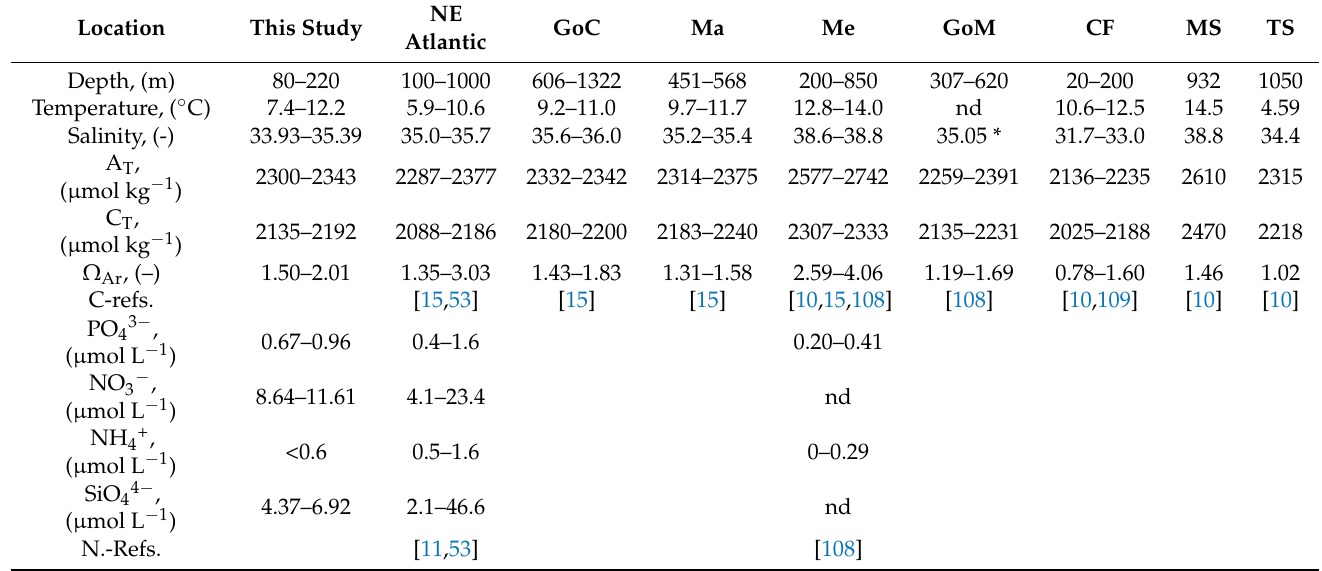
Table 5. The range (published min–max) of environmental conditions at different regions, specifically at the depth and site of known Lophelia pertusa, Madreora oculata, or Desmophyllum dianthus occurrences, comparing data from this study with data available in the literature. Abbreviations: GoC: Gulf of Cadiz, Ma: Mauretania, Me: Mediterranean, GoM: Gulf of Mexico, CF: Chilean Fjords, MS: Marmara Sea, TS: Tassman Seamount, C-Refs.: References for carbon system data, N-Refs.: References for nutrient data, nd: no data reported, * Only mean salinity reported in